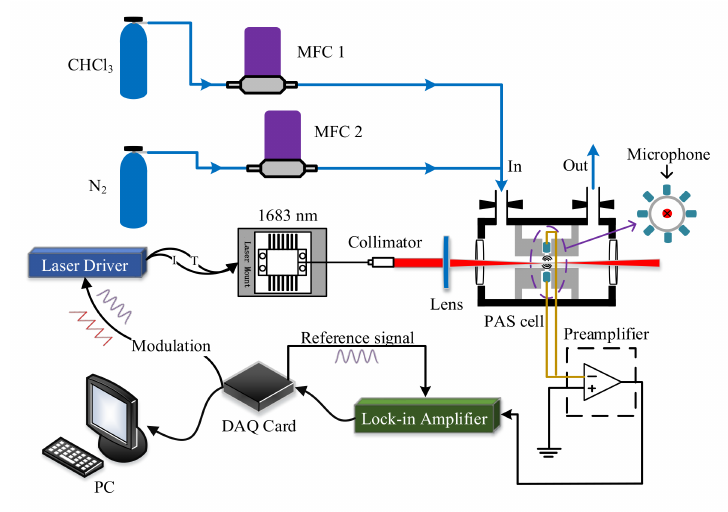
Figure 1. Diagram of the experimental setup for chloroform gas detection.